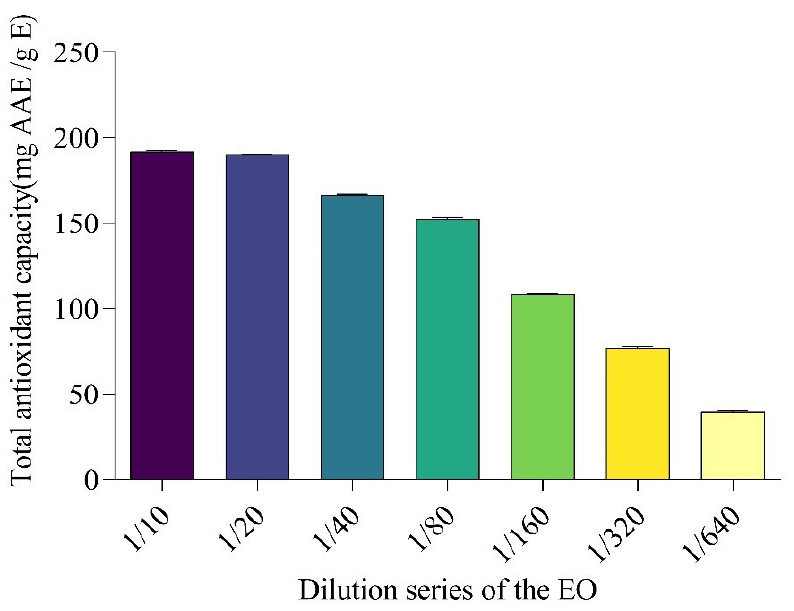
Figure 2. Total antioxidant capacity of the essential oil of D. viscosa, using a series of dilution (mg AAE/g E). Results are expressed as mean ± SD. Table 3. Total antioxidant capacity of the essential oil of D. viscosa dilution series in mg AAE/g E. Results are expressed as mean ± SD.